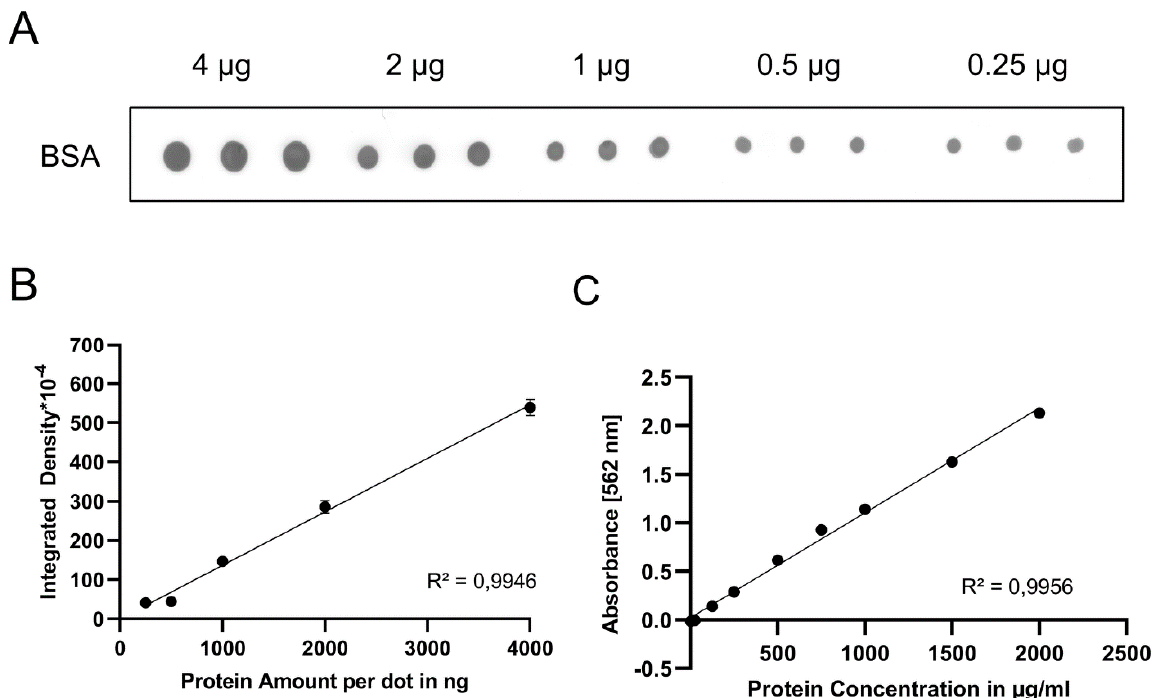
Figure 1. Standard curves of the PDB and the BCA assays. ( A ) Ponceau S-stained dot blot. Variable volumes of a BSA solution (2 µg/µL) containing indicated BSA amounts were spotted in triplicate onto a nitrocellulose membrane. ( B ) Inverted standard curve based on Figure 1A. The experiment was repeated with three batches of BSA solutions. ( C ) Standard curve of three BCA assays performed with different BSA solutions. Error bars indicate SEM. R 2 = Coefficient of determination.